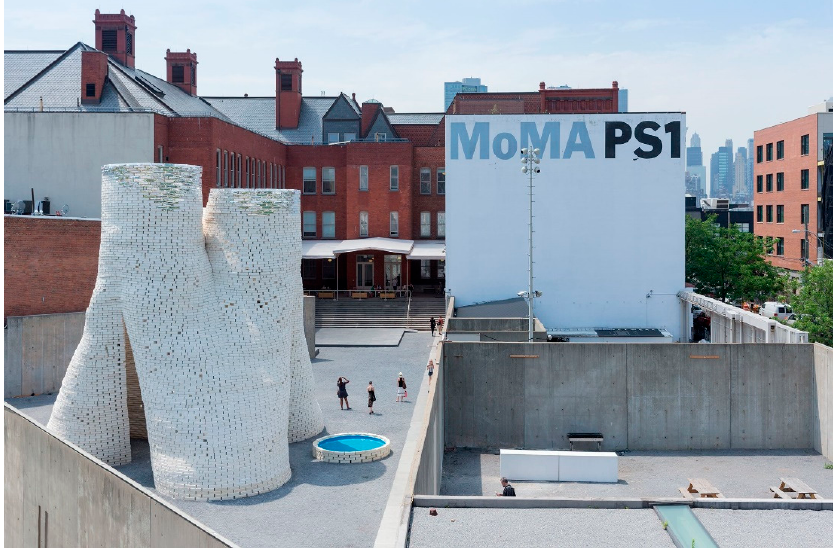
Figure 1. The Hy-fi Tower (Image credit: Iwan Baan).